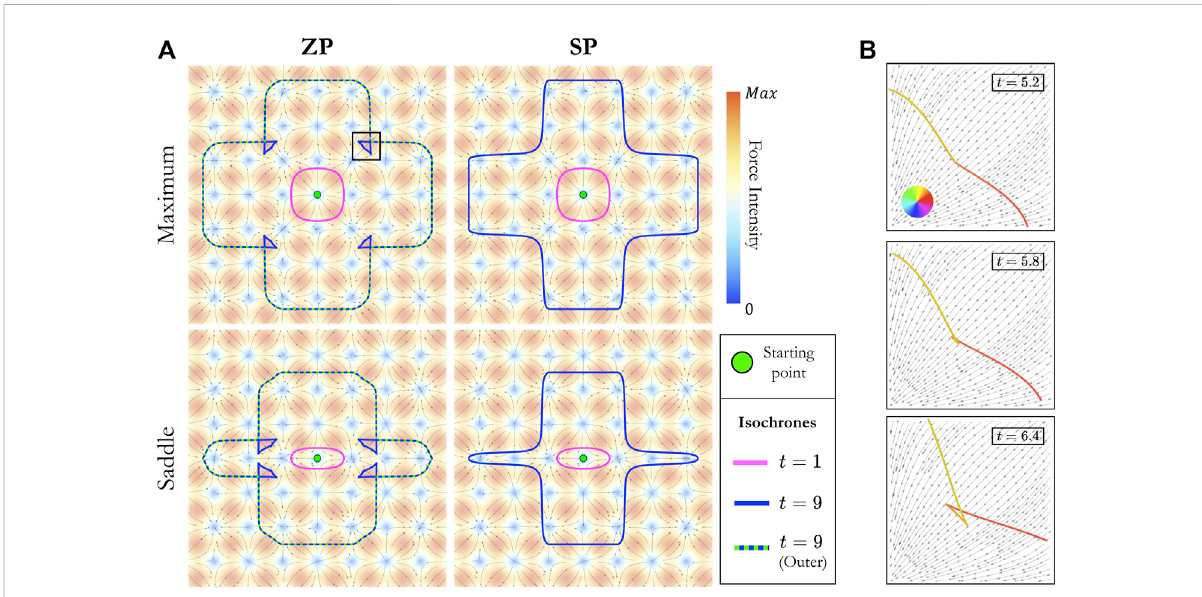
FIGURE 1 Short-time isochrones in the con fi ning regime. (A) Each panel shows two exemplary short-time isochrones at times t = 1 and t = 9 for a relative force strength γ = 0.79. The top and bottom rows correspond, respectively, to a departure point located at a local maximum or a saddle point of the potential (2), leading to different symmetries of the isochrones. Contrary to SP (right column), ZP (left column) exhibits characteristic self-crossings whichallowtrajectoriestocircumventotherwiseinaccessibleregionsofspace.Inallpanels,thecolormapindicatestheintensityoftheexternal force fi eld,andthegrayarrows indicateitsdirection.Panel (B) shows zoomsoftheregionindicatedbytheblacksquarein (A) .Thesethreesnapshots at different times show the formation of a self-intersection and two cusps in the ZP isochrone starting from a local maximum. The color code along the curve stands for the initial orientation of the trajectory as indicated by the color